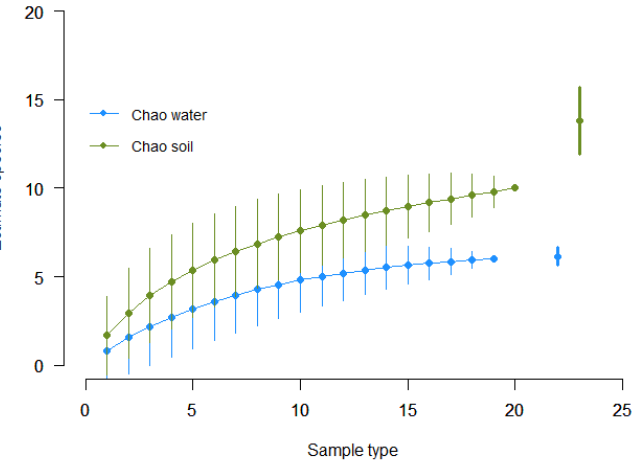
Figure 2. Rarefaction curves with 95% confidence intervals and Chao 2 estimator (points in the right of figure) according to substrate type.